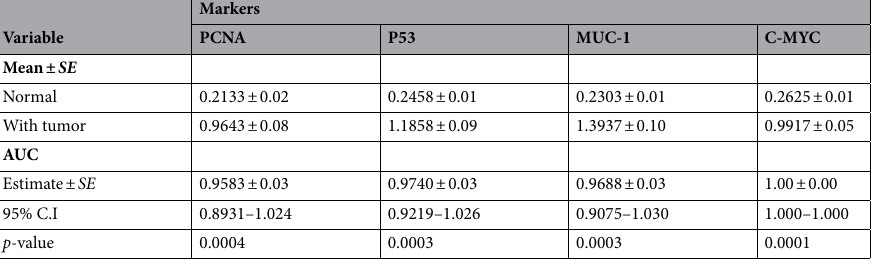
Table 2. Mean ± standard error ( SE ) of AAbs values measured for normal cats ( n = 6) and cats diagnosed with mammary tumor ( n = 32), the area under the receiver operating characteristic curve (AUC) ± SE for the four studied AAbs and their 95% confidence intervals (C.I.), and p -value.